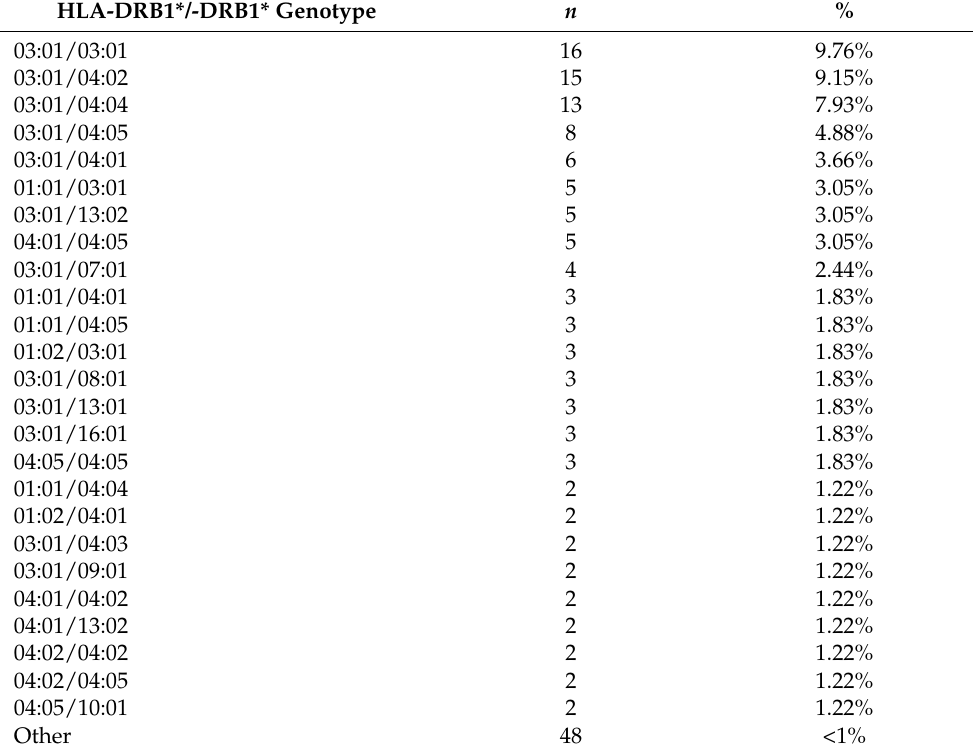
Table 4. Distribution of HLA-DRB1* genotypes in Brazilian patients with type 1 diabetes who reported all parents, grandparents and great-grandparents as White ( n =